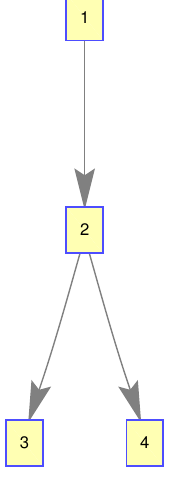
Figure 18. The structure of the single group